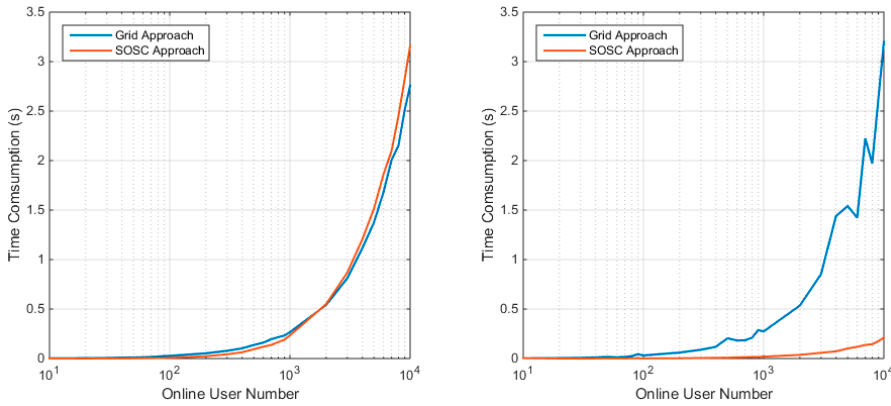
Figure 9. Time consumption of clustering with the grid approach and SOSC approach under uniform distribution ( left ) and clustered distribution ( right ). distribution ( left ) and clustered distribution ( right